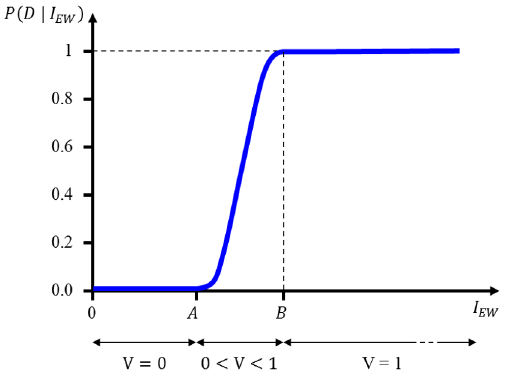
Figure 4. Vulnerability curve.